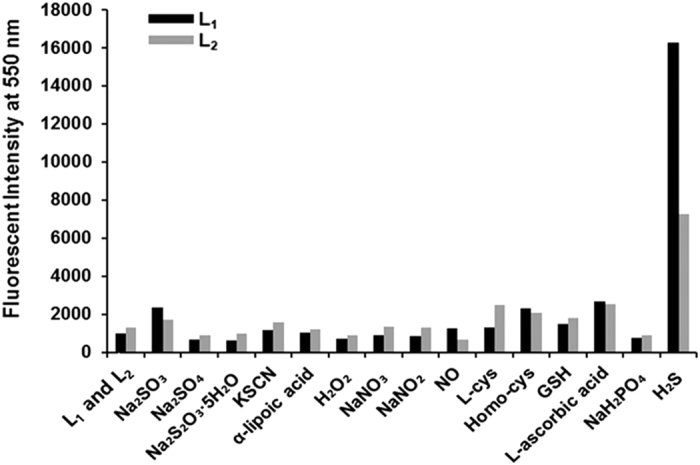
Fluorescence responses of L1 and
L2 (10 μM) toward
sulfur-containing inorganic ions
(S2O3−,
SO42−,
SO32−,
SCN−, 1 mM), inorganic salt
(NaH2PO4, 1 mM), organosulfur compound
(α-lipoic acid), reactive oxygen species
(H2O2, 1 mM), reactive nitrogen
species (NO, NO3, NO2, 1 mM), thiols
(L-cys, homo-cys, glutathione 1 mM), L-ascorbic acid
(1 mM) and NaHS (100 μM) in PBS buffer
(pH 7.4) at 37 °C for 60 min. Excitation
at 435 nm.